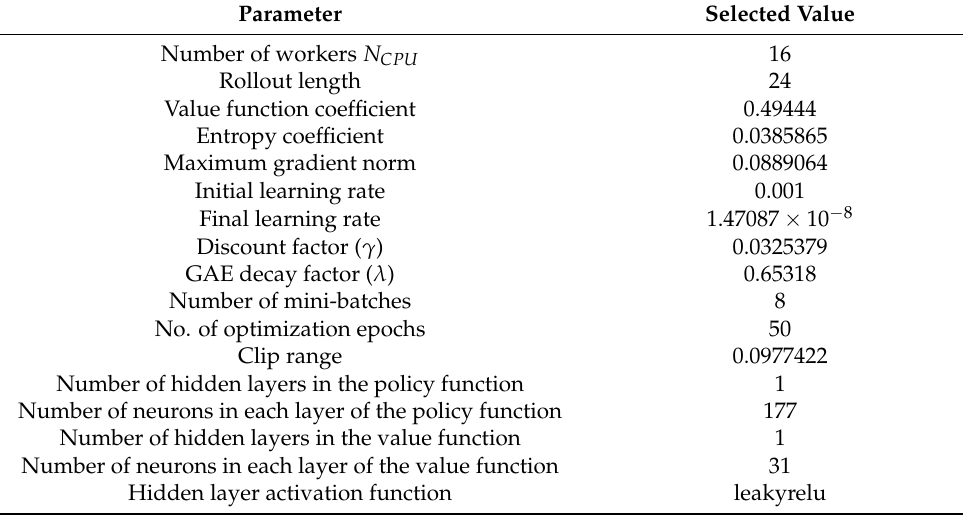
Table 3. Hyper-parameter values selected through hyper-parameter optimization.